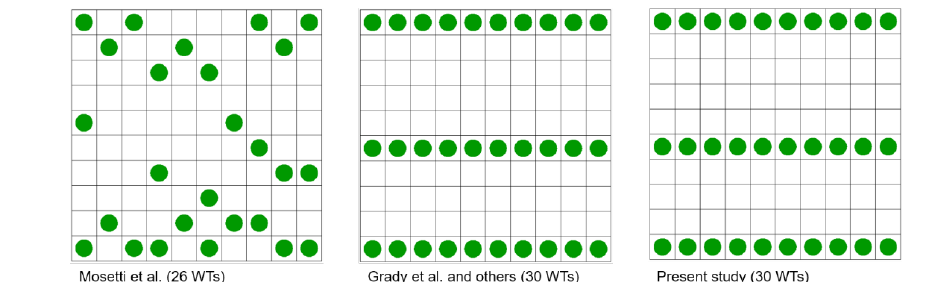
Figure 5. Layout results for case study (a). Table 3. Layout Results for Case Study (a).